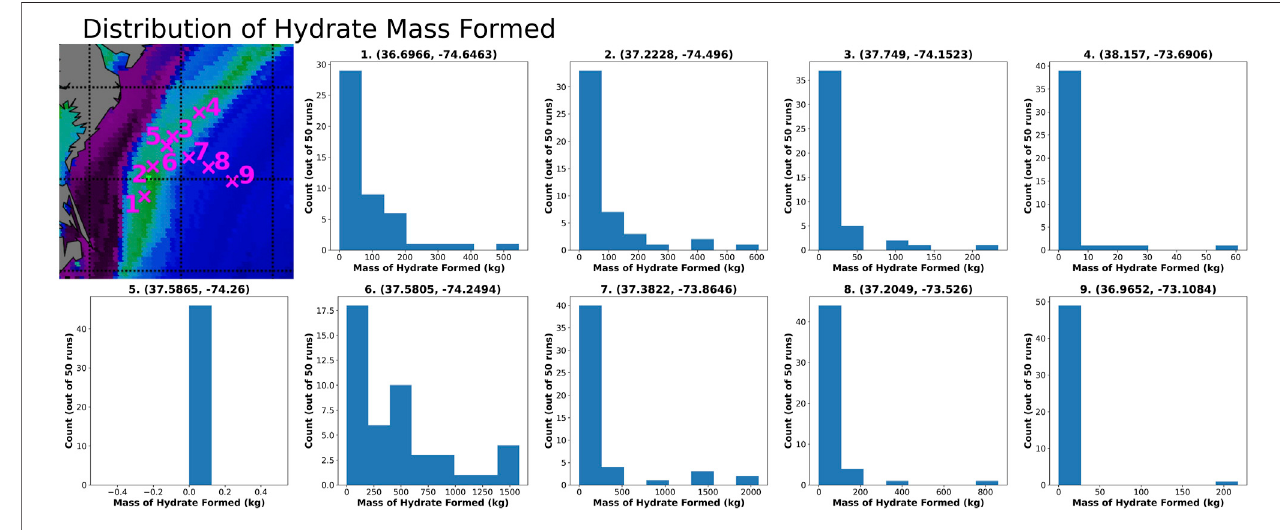
FIGURE 8 | Distribution of the mass of hydrate formed at each location.